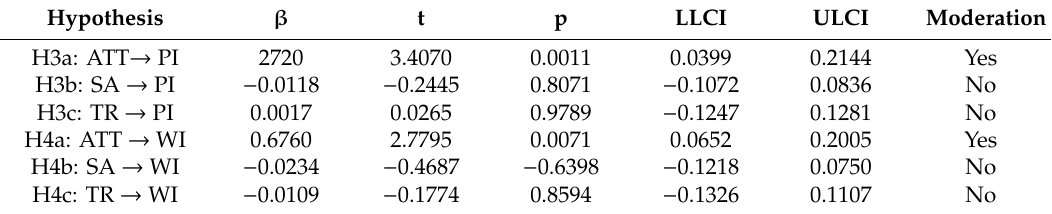
Table 6. Results of the moderation model: environmental